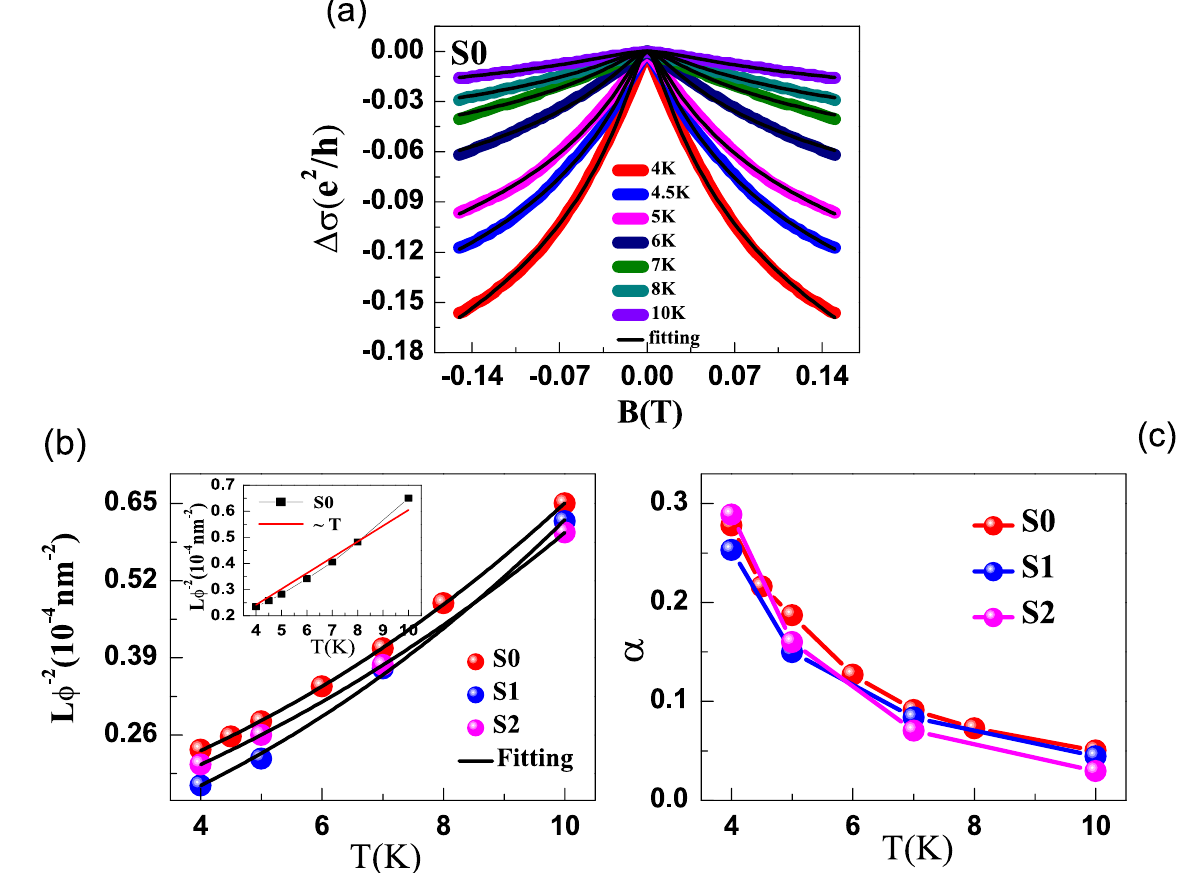
σ ) versus field B at various temperatures for as-grown film S0. Figure 6. ( a ) The magneto-conductance ( △ Solid curves through the data are fits to the HLN equation. ( b ) Variation of L φ as a function of temperature, revealing the contribution of different scattering mechanisms. Inset shows the failure of a linear in T fitting. ( c ) Temperature dependence of α